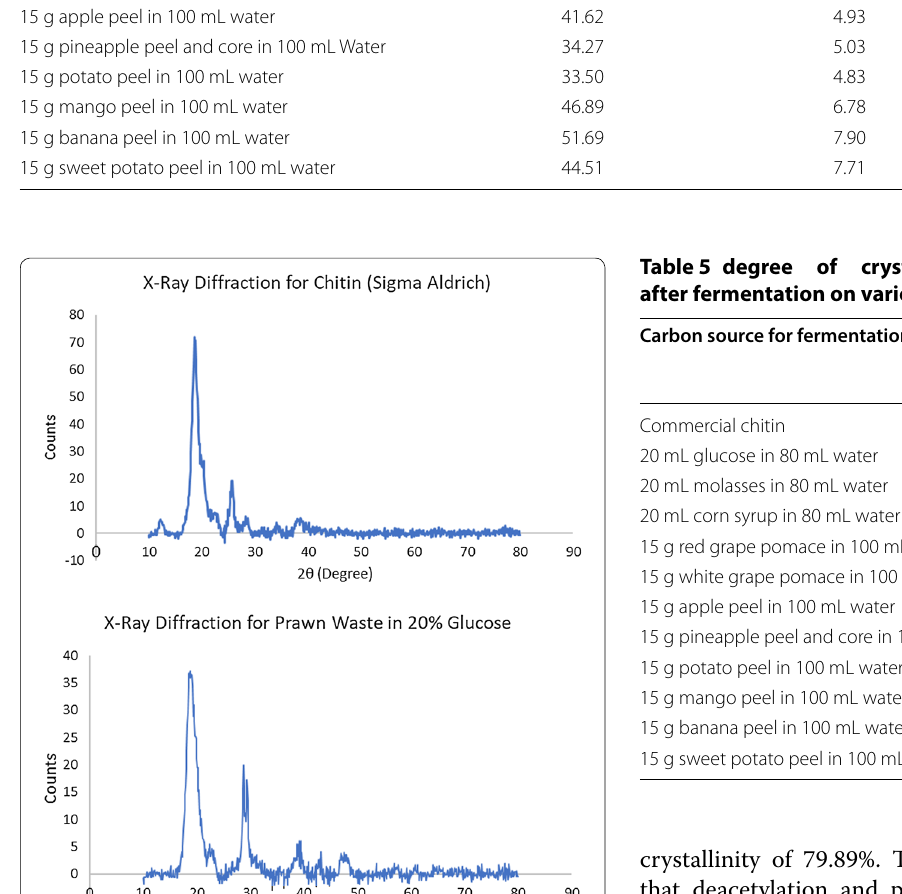
Table 4 Elemental analysis of commercial chitin and chitin extracted after fermentation on various carbon sources Carbon source for fermentation Carbon (%) Nitrogen (%) Carbon/ Commercial chitin